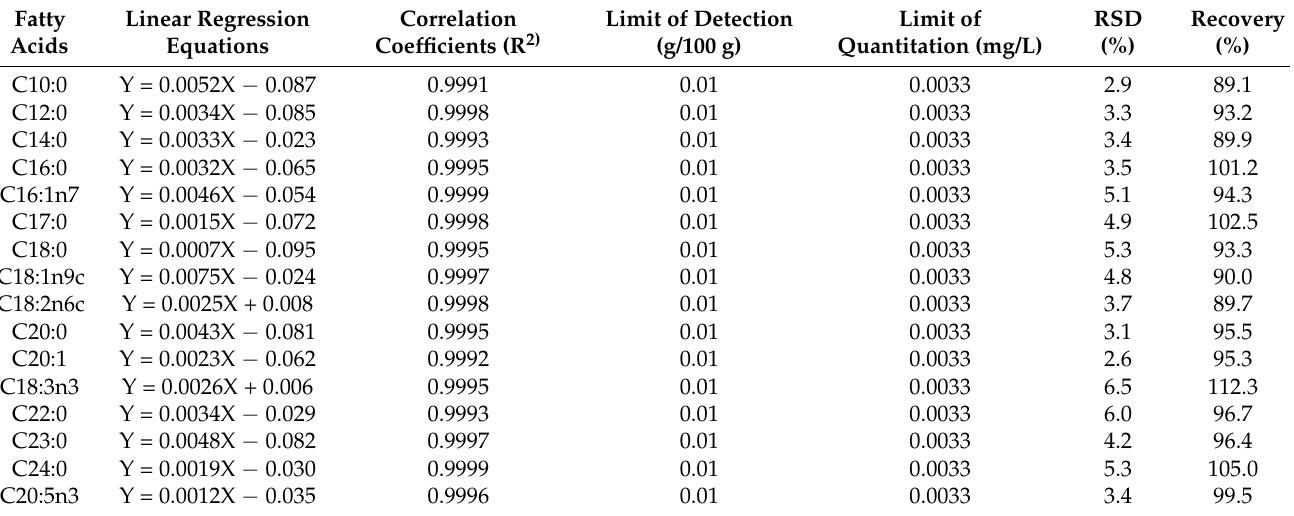
Table 1. Linear regression equations, correlation coefficients, LOD, LOQ, instrument accuracy, and recovery of fatty